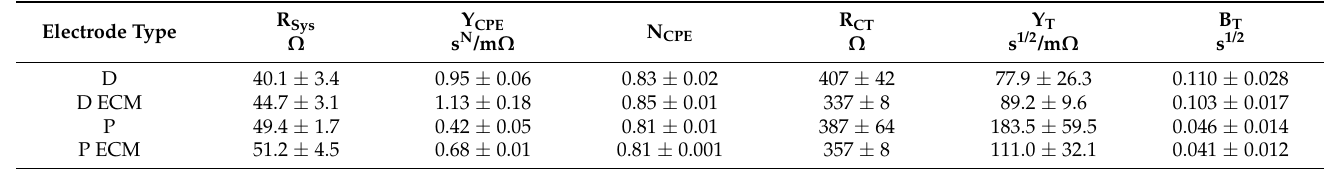
Table 1. Resulting values of the impedance data on the electrical schematic in Figure 3d. Compared were the basic carbon nanofiber electrode, dense (D) and porous (P), as well as the ECM modified samples. R Sys describes the systemic electrical resistance of the whole measurement setup; Y CPE the admittance of the CPE; N CPE the ideality of the CPE; R CT the charge transfer resistance; Y T the admittance of the diffusion element; and B T the time constant of the diffusion element. Electrode